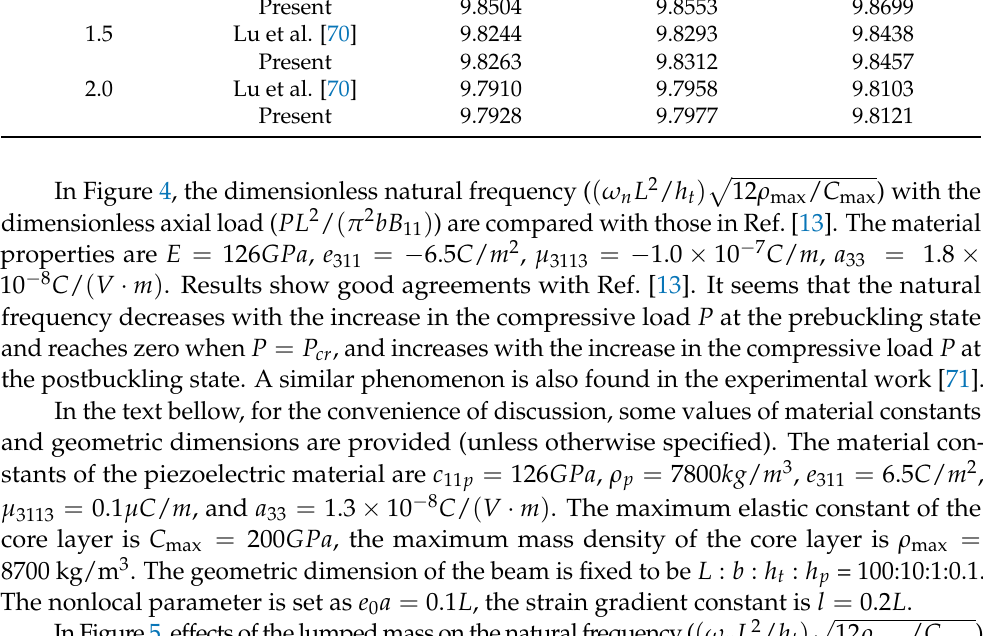
(cid:112) 12 ρ max / C max ) with available date with